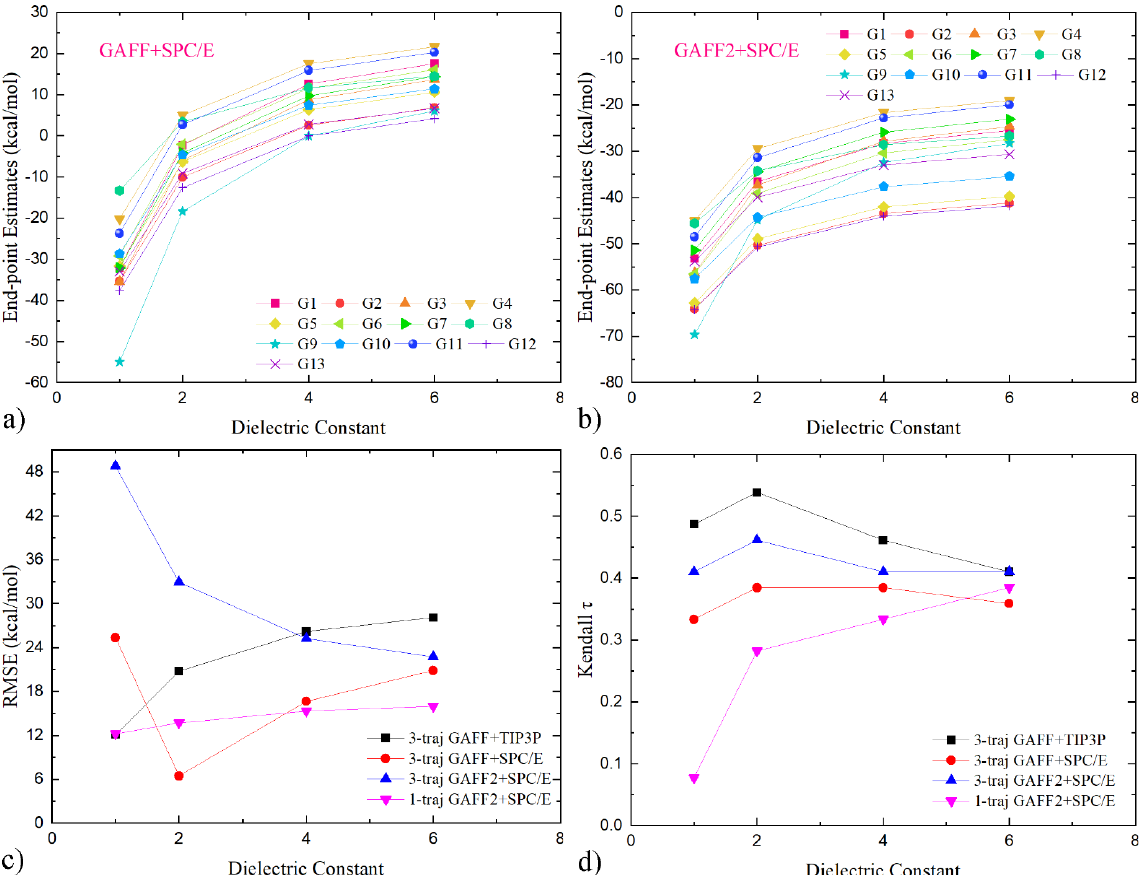
Figure 4. Dependence of three-trajectory MM/GBSA estimates on the dielectric constant for the modelling sets of ( a ) GAFF+SPC/E and ( b ) GAFF2+SPC/E. Clearly, the computed binding affinities of all host–guest pairs exhibit monotonic increasing behaviors with respect to the interior dielectric constant. This systematic increasing trend differs from the single-trajectory case, where system-dependent responding behaviors are observed. ( c , d ) Quality metrics for dielectric constant calculations with different modelling parameters. The single-trajectory results with the GAFF2+SPC/E parameter set are also shown for comparison. Under the three-trajectory regime, the response of RMSE seems to be parameter-set-dependent. The increase in the internal dielectric constant betters the reproduction of the absolute values of binding affinities under GAFF2+SPC/E but worsens the situation under GAFF+TIP3P, while under GAFF+SPC/E a non-monotonic trend is observed. Unlike the large variations in RMSE, minor perturbations are introduced to the ranking information. The ranking τ of the best-performing set GAFF+TIP3P in the three-trajectory realization can be bettered to ~0.54 with the adjustment of the interior dielectric constant.